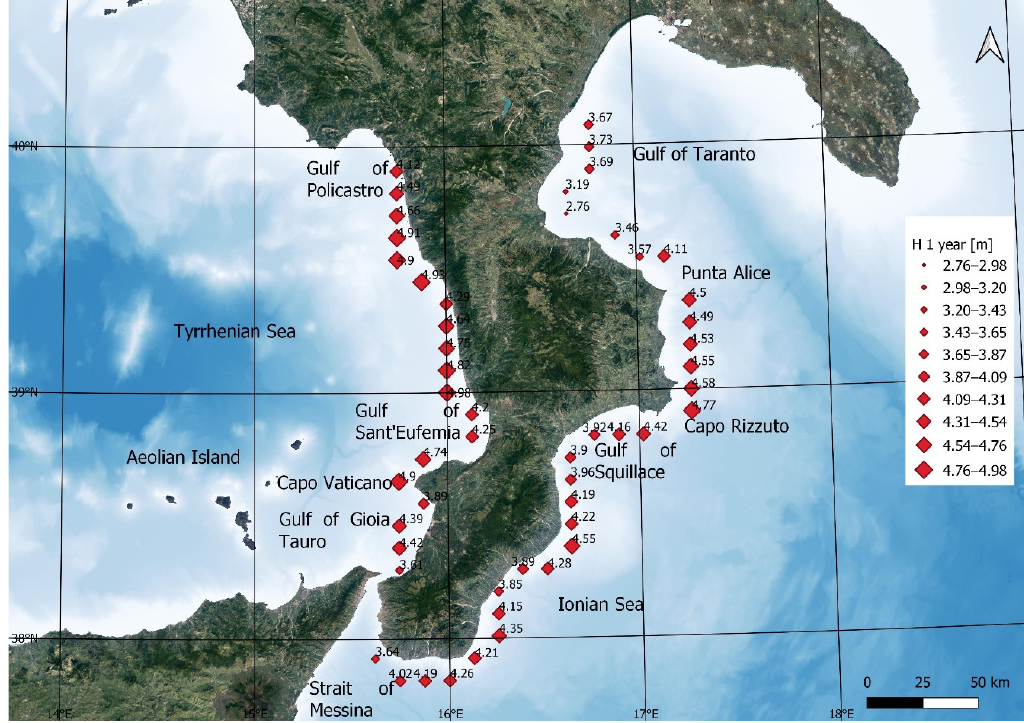
Figure 5. Significant wave height of return period of 1 year h s 1 values. The range between the minimum and the maximum values has been divided into 10 intervals of the same width.